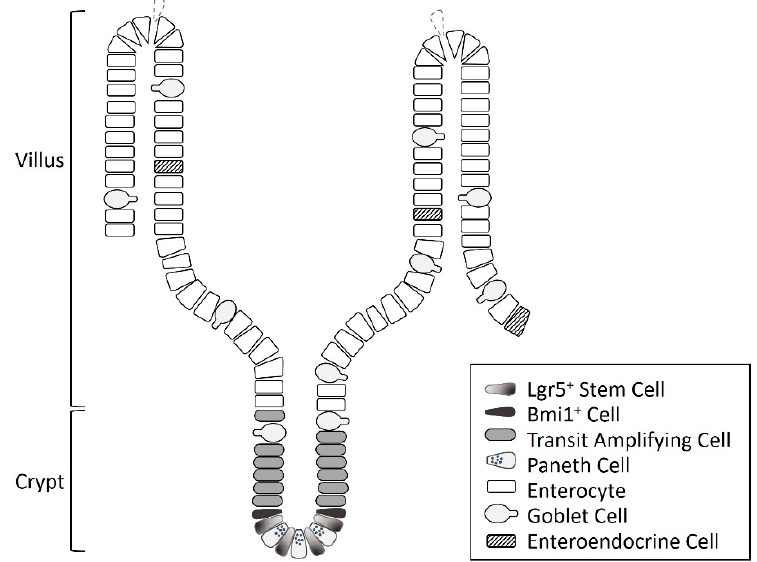
Figure 1. The diagram of the cell types and structures in the intestine